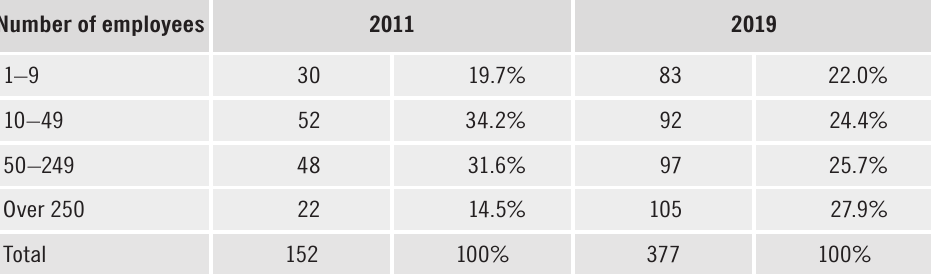
Table 2. Distribution of companies surveyed by the number of employees and reference year